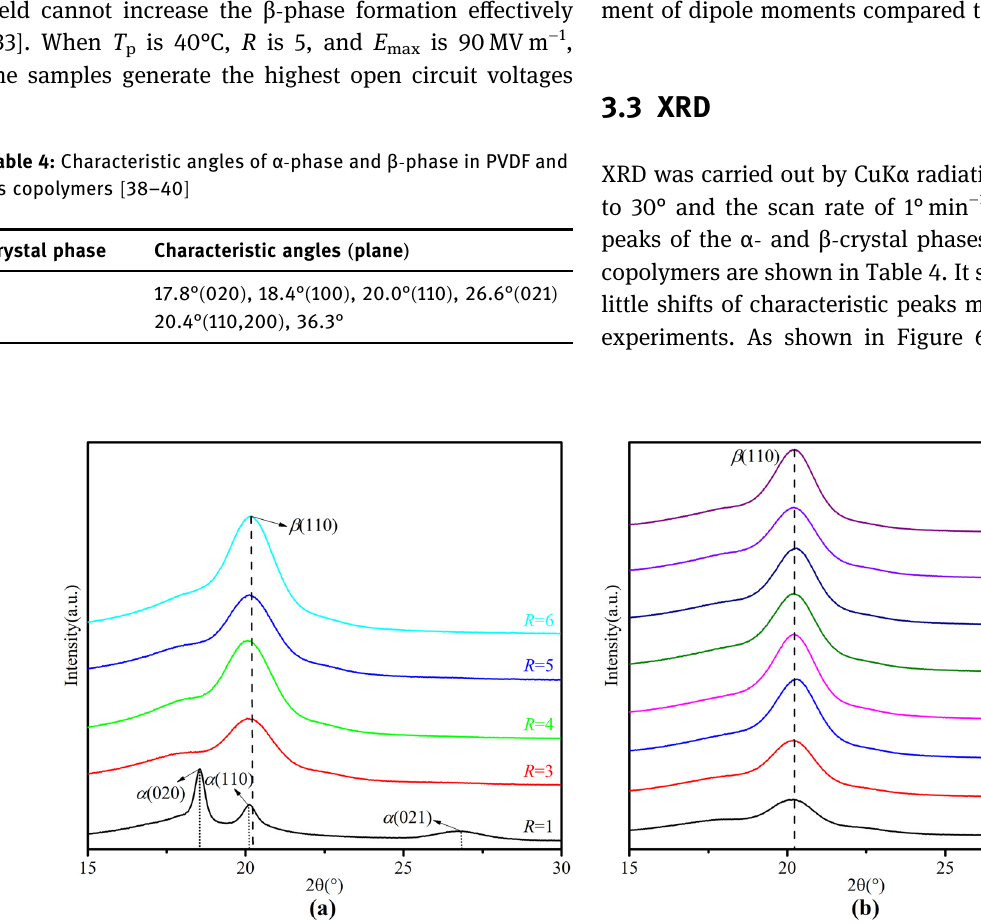
Figure 6: XRD di ff raction spectrogram of PVDF - HFP fi lms: ( a ) stretched plus poled fi lms at various elongation ratios ( T p = 40°C ) and various poling temperatures ( R = 5 ) ; ( b ) stretched fi lms at various elongation